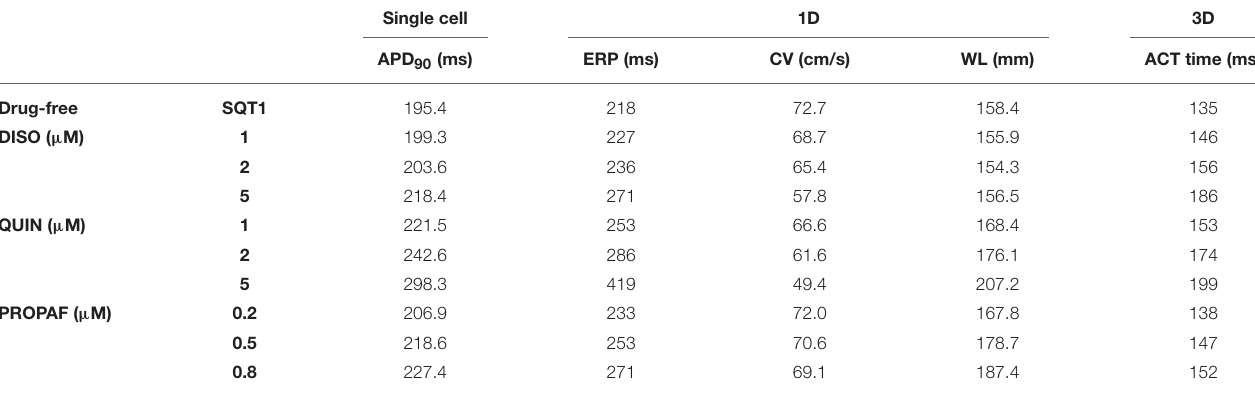
TABLE 2 | A summary of multi-scale pharmacological simulation